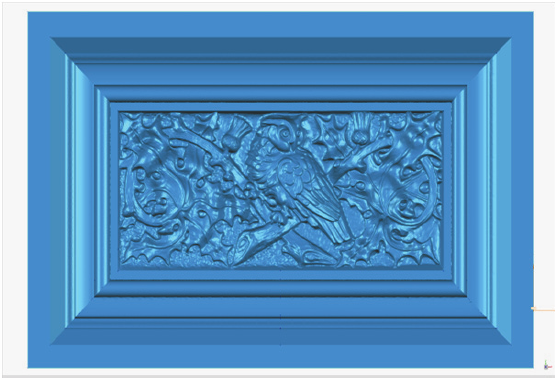
Figure 8. Polygon mesh model of the maquette created using a Creaform Handyscan